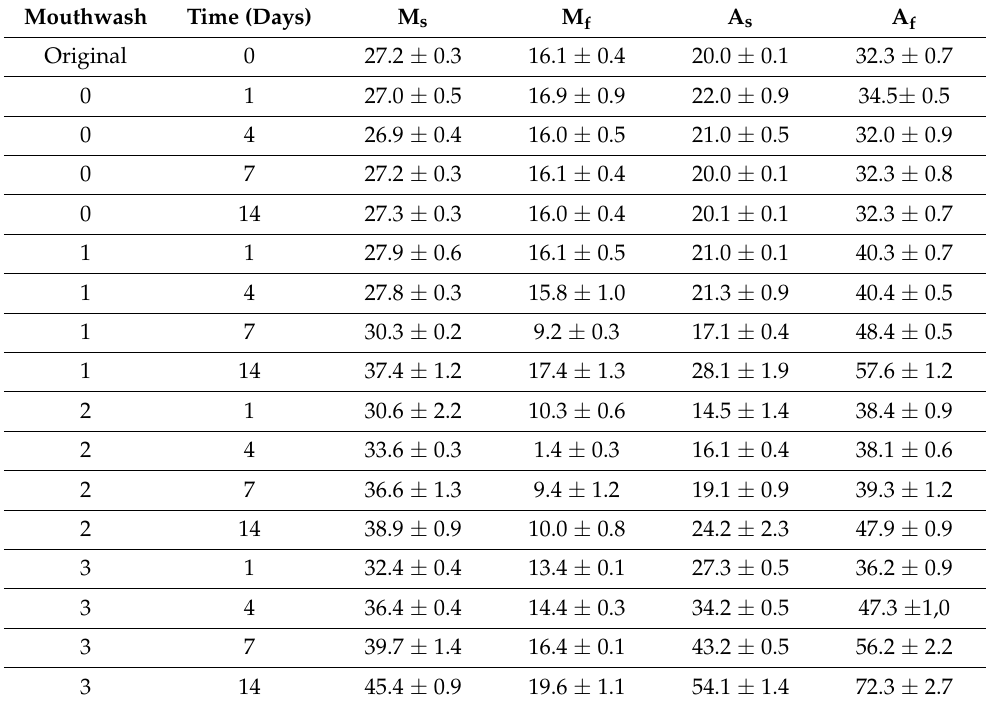
Table 3. Transformation temperatures ( ◦ C) for the Ni-Ti archwires studied with the different immer- sion times for each mouthwash.